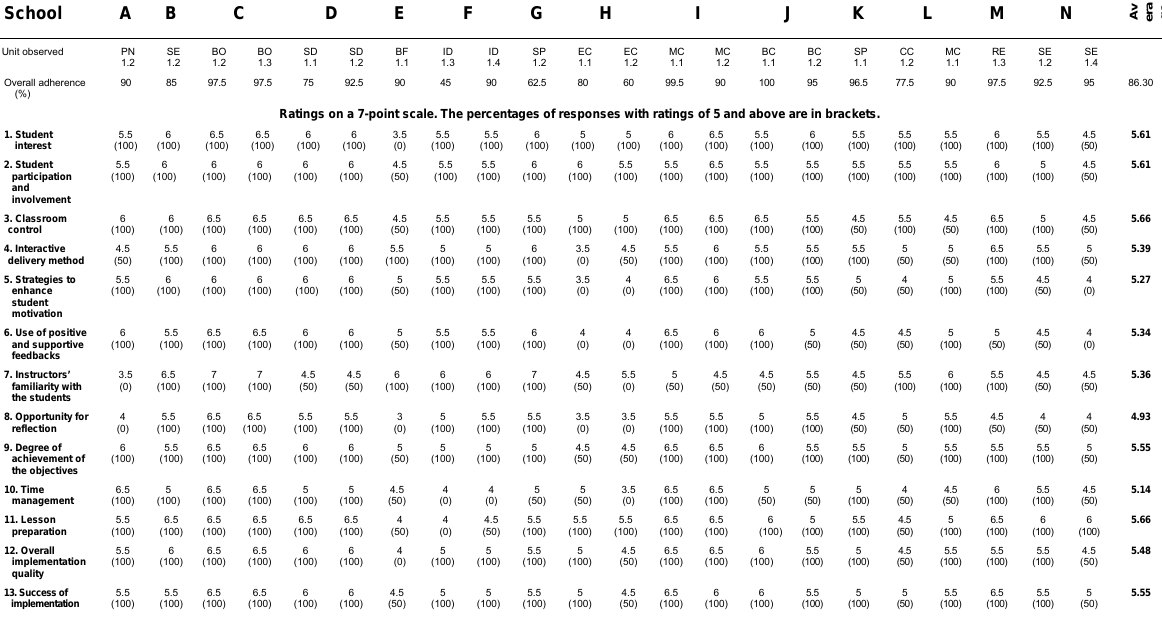
Overall Ratings on Each Unit Observed in the Different